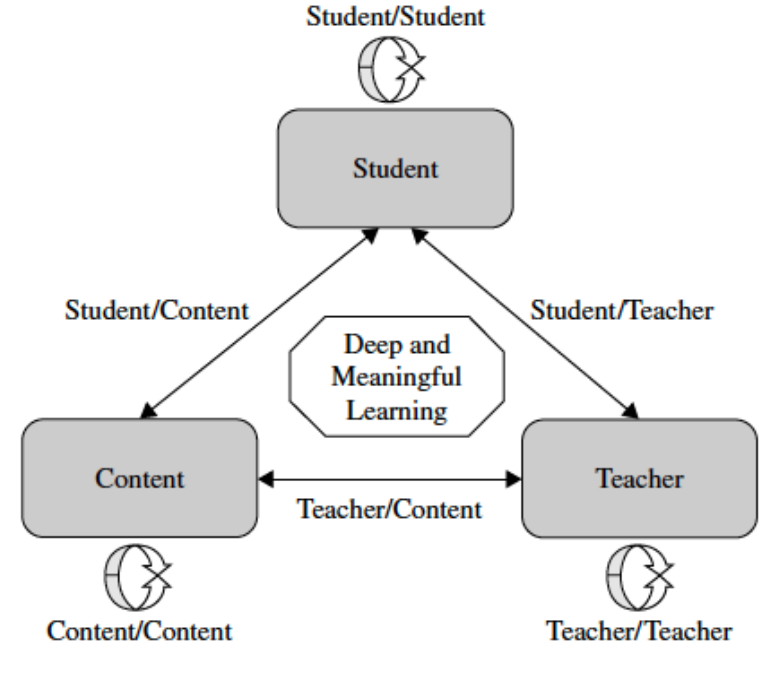
Figure 1. Modes of interaction in distance education from Anderson